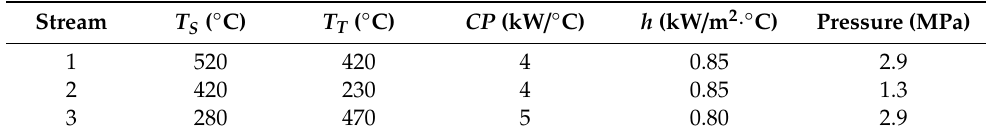
Table 1. Stream data for Example